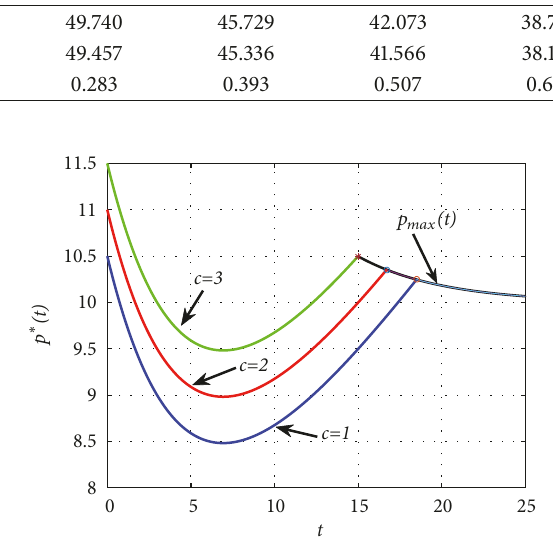
Figure 8: The optimal dynamic pricing strategy with different 𝑐